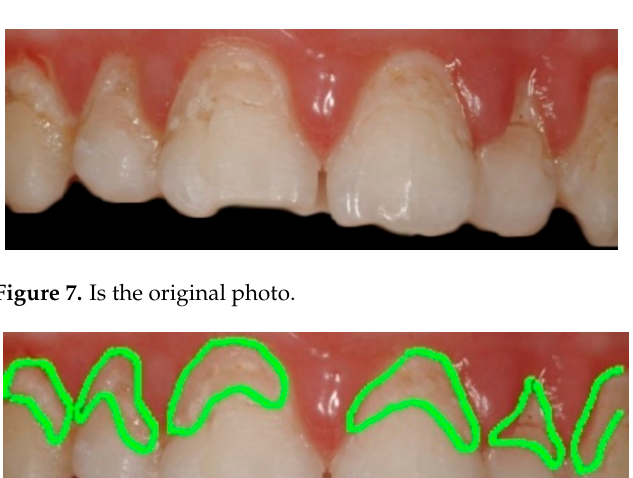
Figure 8. Shows the original image with the traced contours of the erosion area.